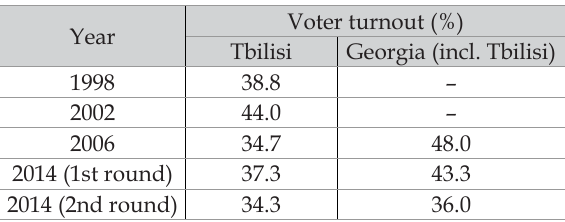
Table 1. Voter turnout in local elections in